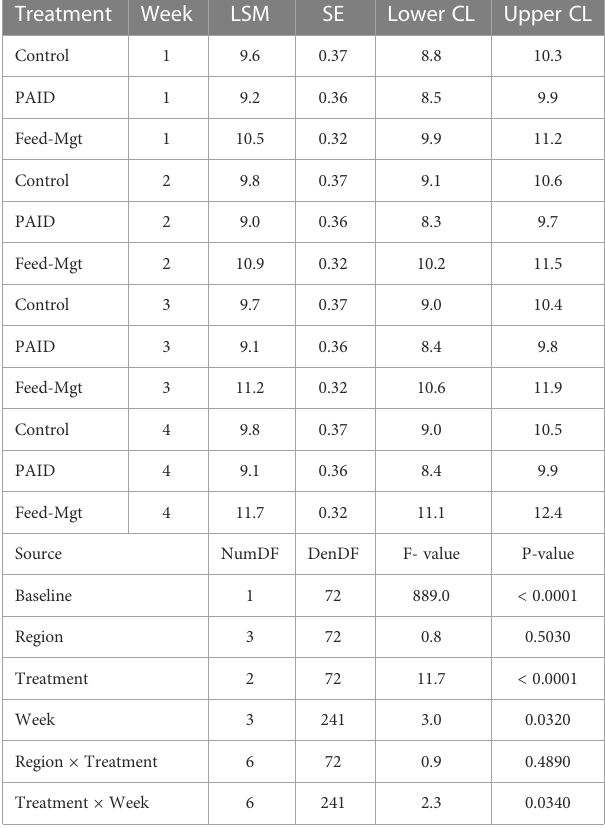
TABLE 4 Effect of feed, management-related trainings, and genetics on milk production (L/d) of dairy cows under smallholder farmers.